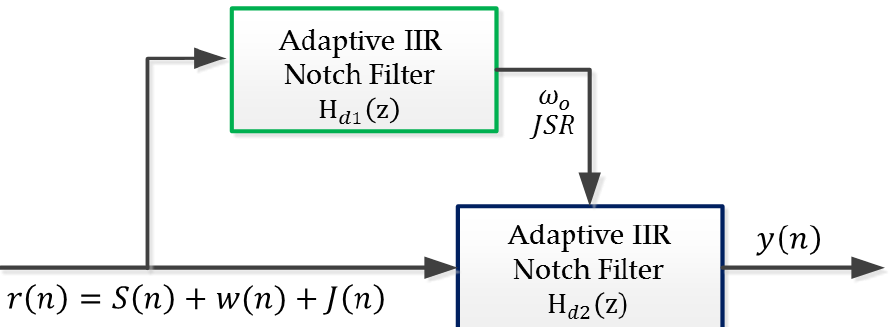
Figure 4. Block diagram of the proposed suppression system model.